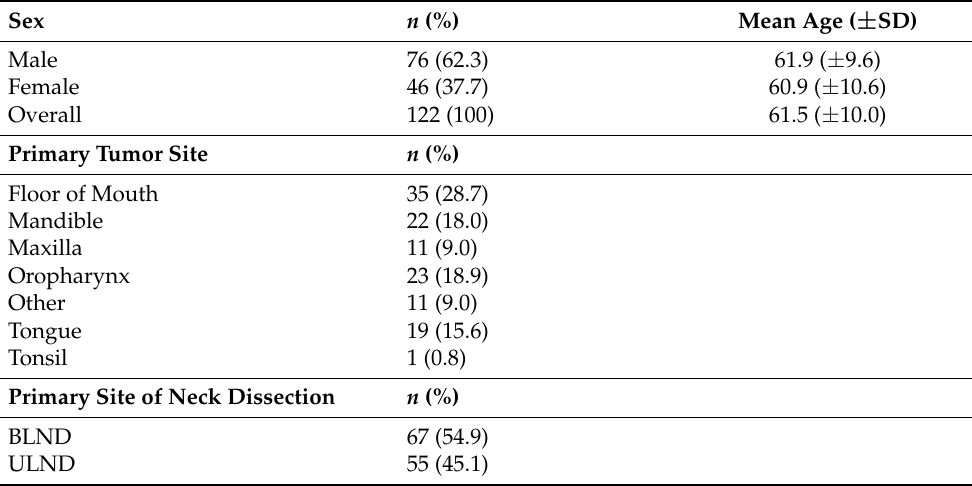
Table 1. Categorical distribution of cases ( n = 122) (SD: Standard Deviation) and distribution of primary tumor site and neck dissection ( n = 122) (Maxilla: Maxilla/Upper Jaw/Upper Alveolar Ridge, Mandible: Mandible/Lower Jaw/Lower Alveolar Ridge, Other: Lip/Cheek/other Oral Cavity, BLND: Bilateral Neck Dissection, ULND: Unilateral Neck